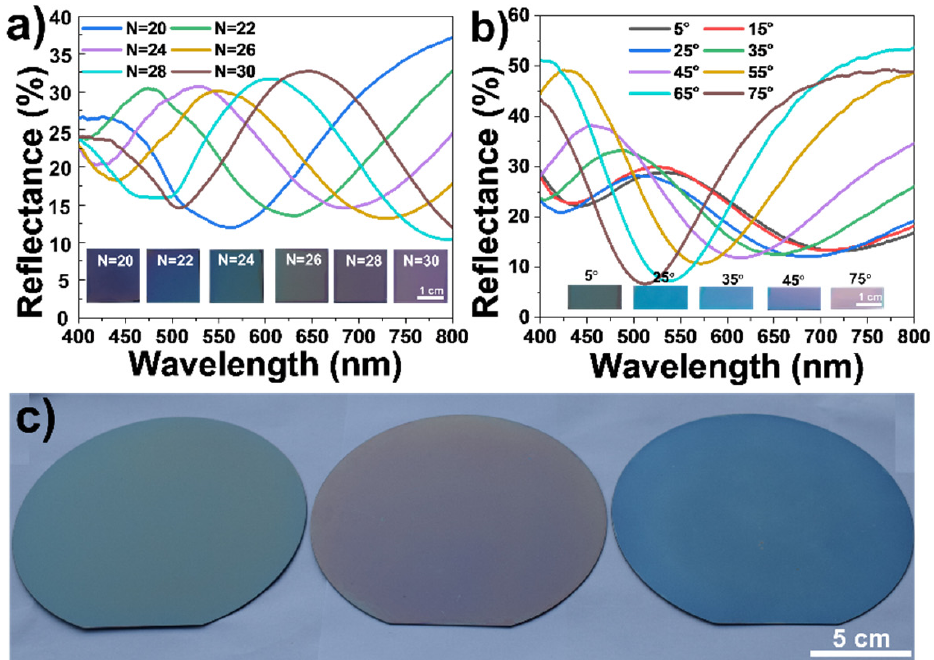
Figure 7. ( a ) Digital photographs and reflectance spectra. ( b ) Reflectance spectra of structural color film with spray passes of 26 at different incident angles. ( c ) Photographs of structural color films at an incident angle of 15°.